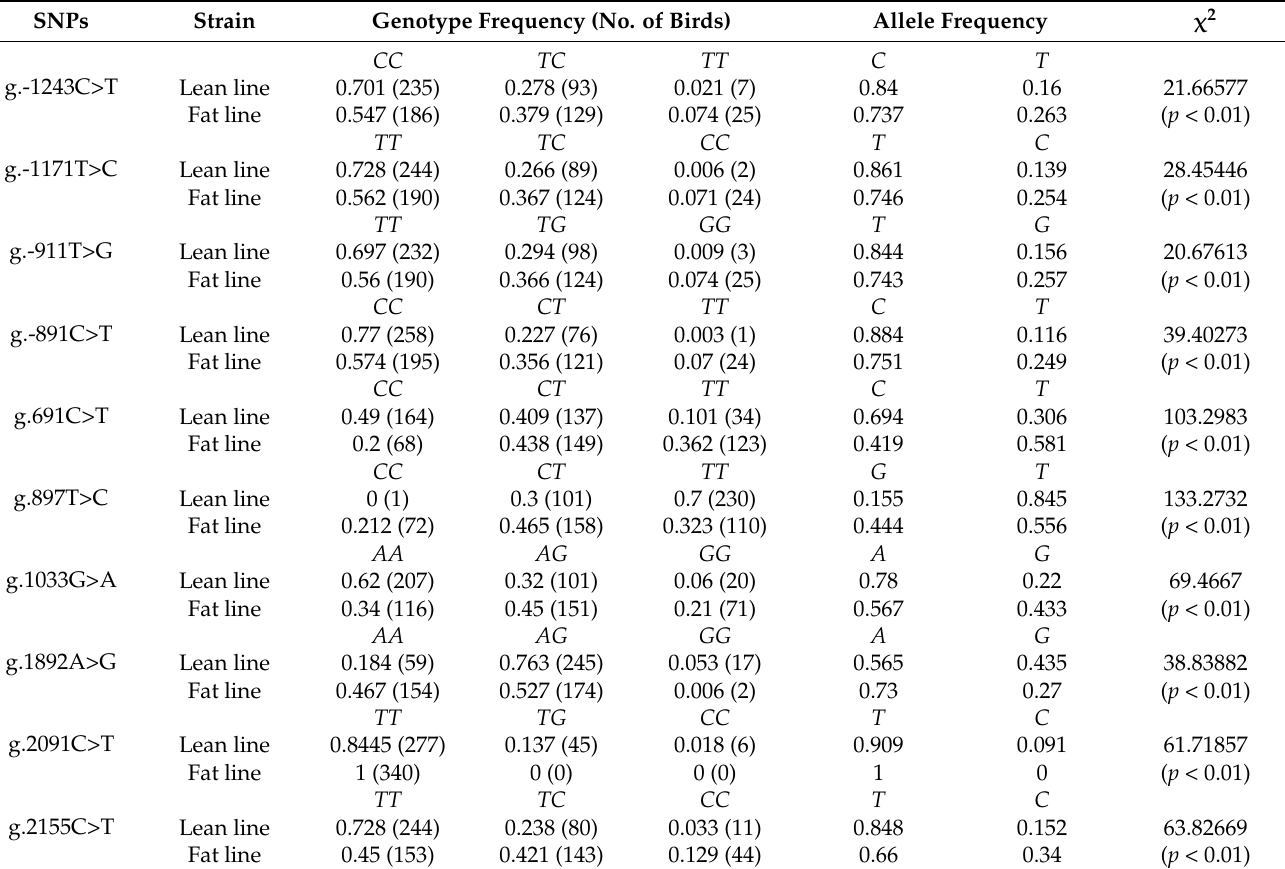
Table 2. The differences in allele frequencies of SNPs between the lean and fat lines.